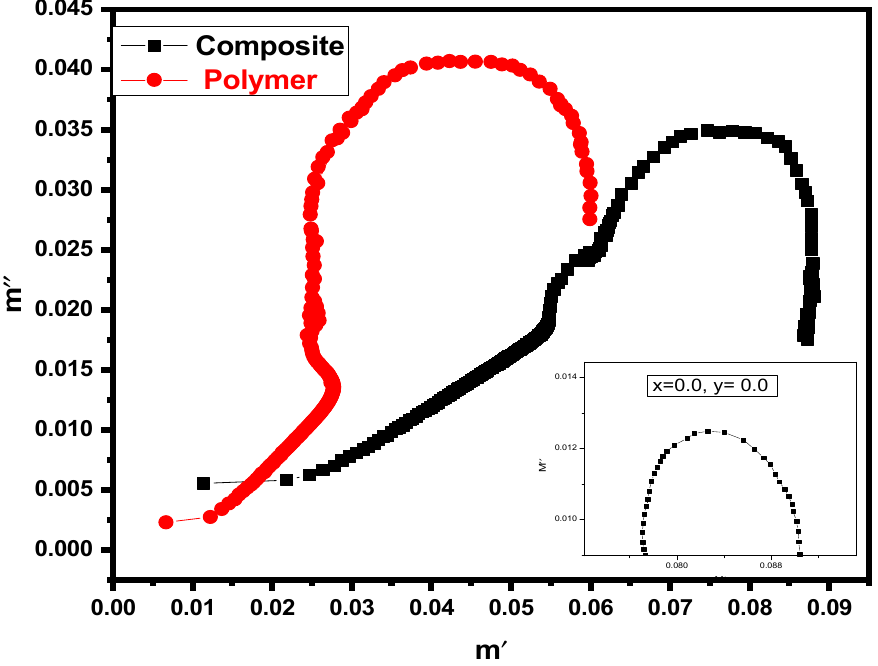
Figure 10. Cole-Cole plots of electric modulus with the frequency of Y-type hexaferrite Sr 2 Co 2 Fe 12 O 22 , composite (Sr 2 Co 2 Fe 12 O 22 + PPy-DBSA) and polymer PPy-DBSA.